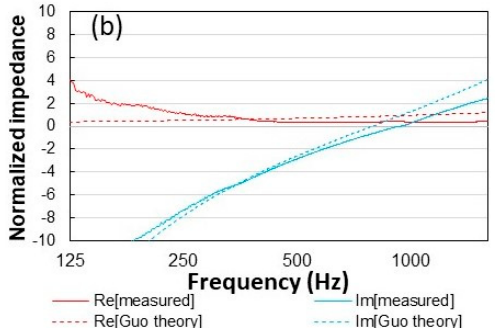
Figure 8. Comparison of the measured (solid line) and calculated (dashed line) values of the normal absorption coefficient ( a ) and specific impedance ( b ) of Specimen #2, with an air-back cavity of 25 mm depth.